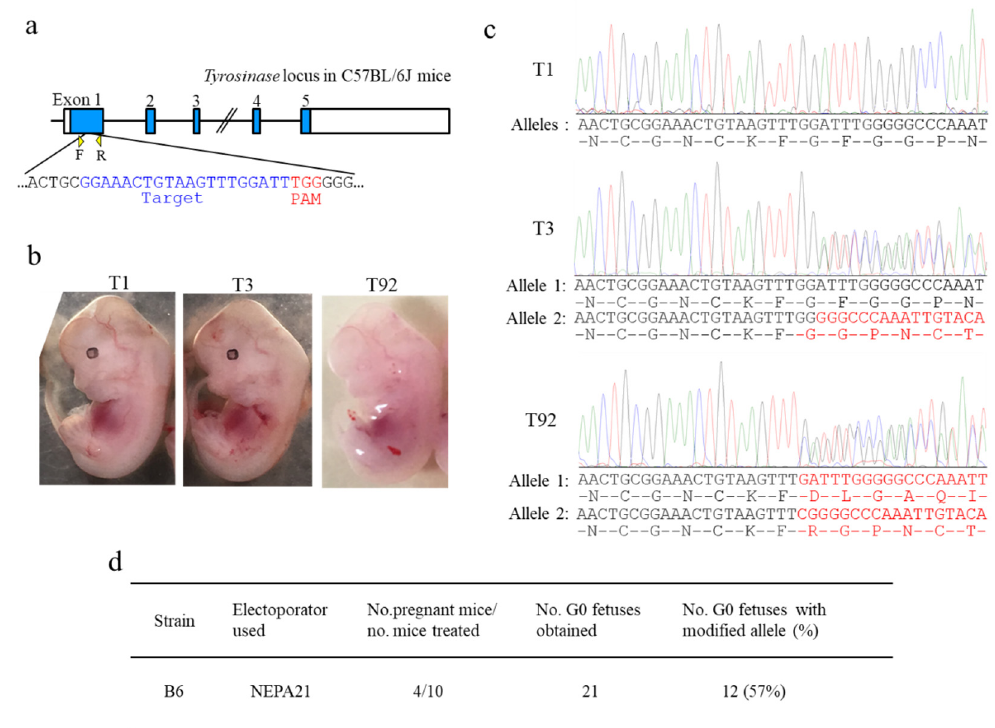
Figure 2. i -GONAD-based targeted disruption of tyrosinase gene ( Tyr ) in B6 mice using NEPA21 electroporator under the electric conditions of Tp 40 V, 162 Ω (on average), and ≈ 100 mA. ( a ) Gene structure of Tyr in B6 mice. The target sequence present on exon 1 of Tyr and recognized by guide RNA (gRNA) is shown in blue. Primers F and R used for amplification of a region spanning the target sequence are shown below the Tyr . Protospacer adjacent motif (PAM) is shown in red. Blue color in each exon corresponds to tyrosinase protein. ( b ) Mid-gestational fetuses (T1, T2, and T92) obtained from i -GONAD-treated plug- positive B6 females. Clearly, the T92 fetus exhibited depigmented eyes. ( c ) Direct sequencing of PCR products derived from the fetuses shown in (b). The T1 fetus showing pigmented eyes had wild-type alleles. The T3 fetus showing pigmented eyes is judged as heterozygous mono-allelic knock out (KO) because one allele (called allele 2) had indels, yielding a frameshift of amino acids (shown by red). The T92 fetus is judged as heterozygous bi-allelic KO because both alleles had indels, each yielding different frameshifts of amino acids (shown by red). ( d ) Genome editing efficiency of the Tyr locus at B6 strain . 3.3. i-GONAD-Based KI Induction Using BALB/c Mice The production of genome-edited mice of the BALB/c strain was also extremely poor when NEPA21 was used as an electroporator [17]. To examine whether the current can also be an important factor for determining the successful production of genome-edited BALB/c fetuses, we performed i - GONAD-based KI. BALB/c mouse has depigmented eyes, as it has a mutation in exon 1 of Tyr (Figure 3a). For this experiment, we used gRNA targeted to a sequence spanning a mutation site (C) on exon 1 of Ty r and 130 bp oligodeoxynucleotides (ODNs; containing normal nucleotide G at the mutated site) as a donor (Figure 3a). At first, i -GONAD was performed on plugged BALB/c females (obtained after natural mating) under electric conditions of Tp of 40 V and resistance of 100–200 Ω using the NEPA21 electroporator, the same as how the initial i -GONAD was performed using B6 mice. Unfortunately, we failed to obtain viable fetuses from the seven females tested. The resistance ranged from 108 to 186 Ω (131 Ω on average), and the current ranged from 205 to 526 mA (368 mA on average) (Tables 1 and S3). Next, we performed i -GONAD using the electric conditions of Tp of 40 V and resistance of 350–400 Ω with the NEPA21 electroporator. Three (21%; BALB-5, -18, and -23) of 14 BALB/c females had a total of 16 mid-gestational fetuses (5.3 on average) (Table 1). Two (13%) of these 16 fetuses showed pigmented eyes (as exemplified by the fetus numbered T16 in Figure 3b), suggesting successful KI in at least one